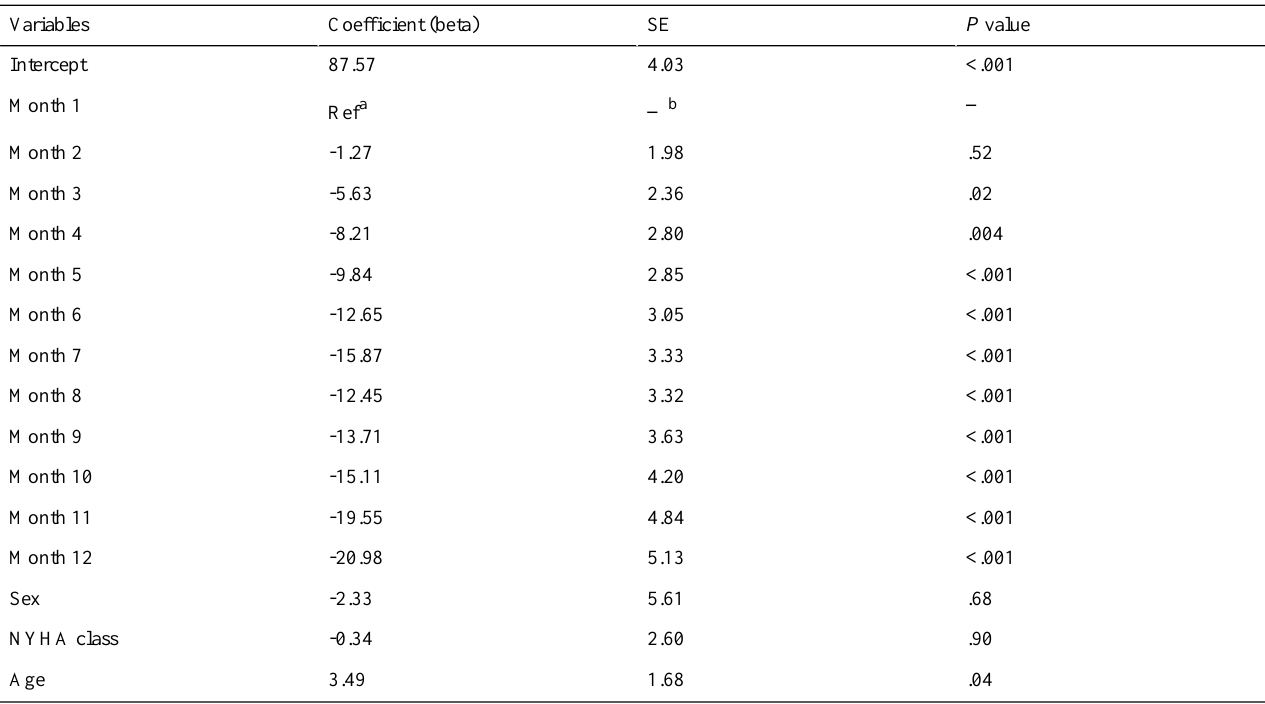
Table 2. Random effects multivariate regression with cluster-robust standard errors (SE) showing the effect of time, sex, New York Heart Association (NYHA) class, and age on average adherence.